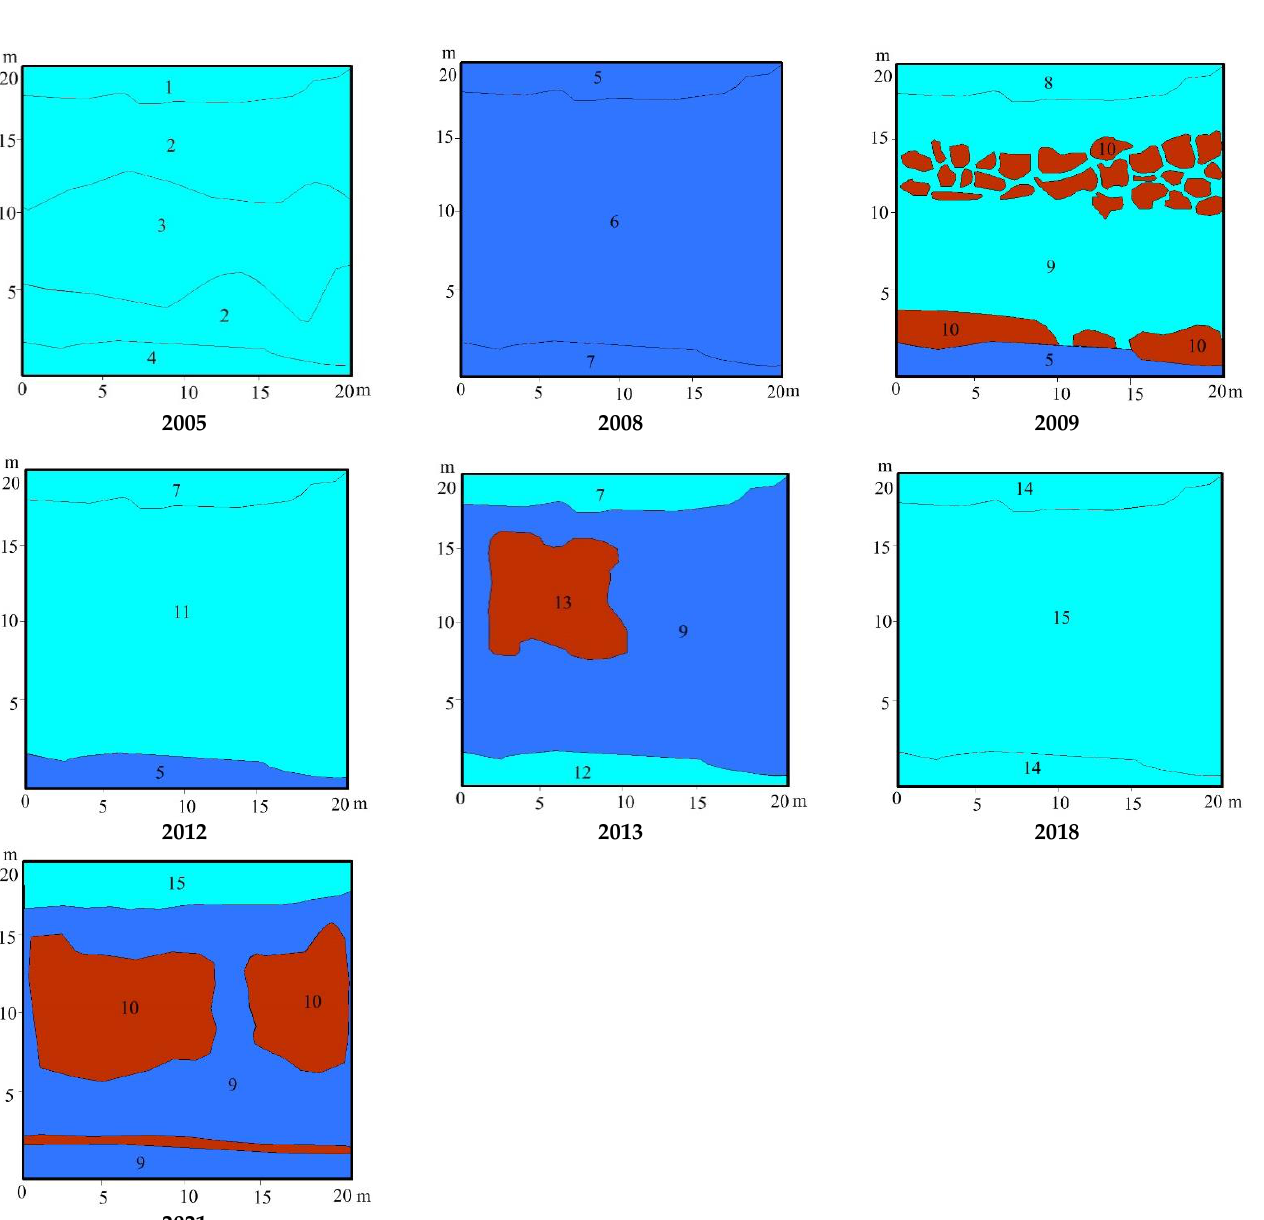
Figure 17. Changes in vegetation on permanent plot No. 3: 1 Salix cinerea – Carex canescens – Poly- trichum juniperinum ; 2 Typha latifolia ; 3 T. latifolia + Epilobium adenocaulon ; 4 C. canescens + Eriophorum angustifolium – Warnstorfia fluitans ; 5 bushes of S. cinerea ; 6 Scirpus radicans ; 7 S. cinerea – T. latifolia ; 8